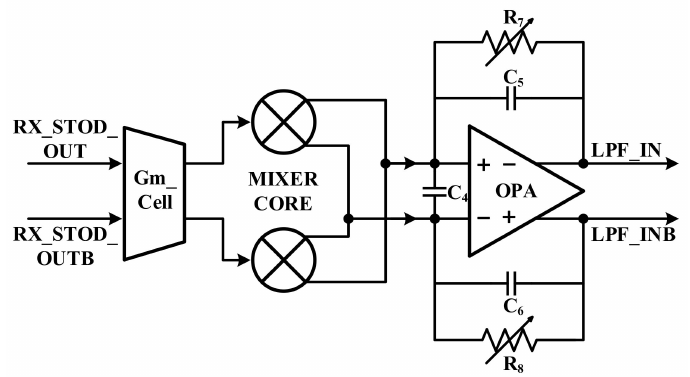
Figure 15. Block diagram of the receiver mixer.